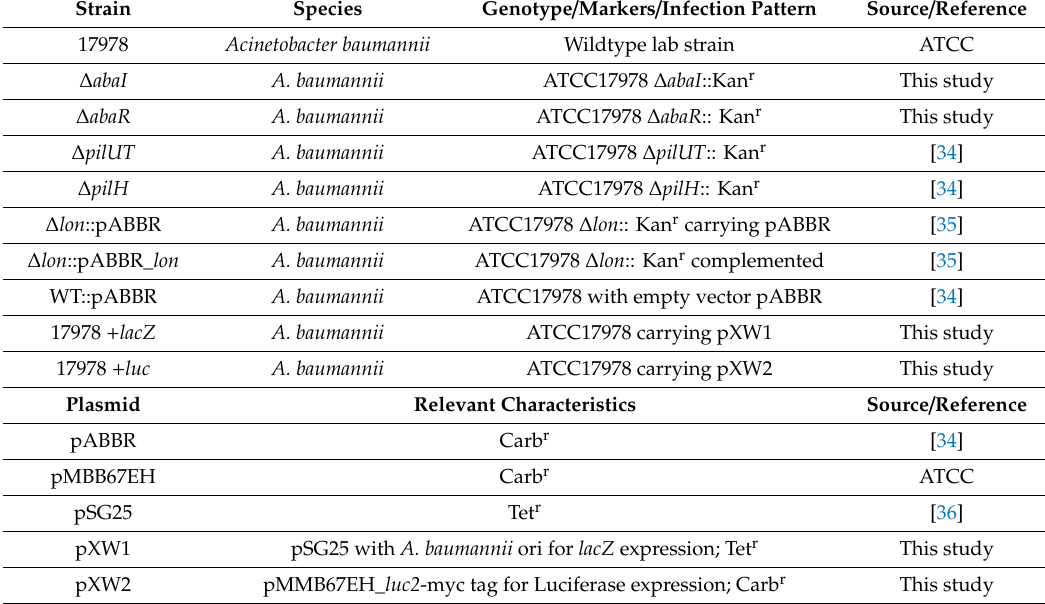
Table 1. Bacterial strains and plasmids used in this